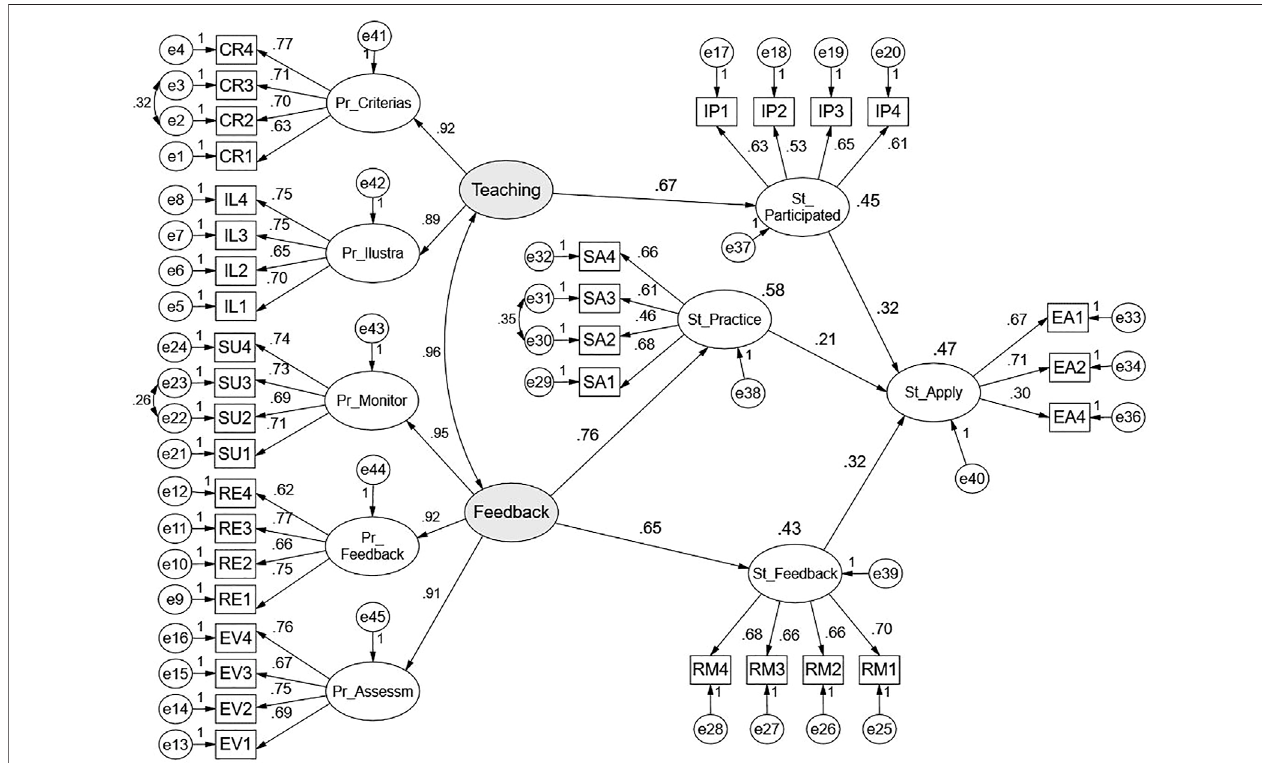
FIGURE 3 | Structural regression model of Teaching and Feedback perceived on the students ’ didactic performances. Note. Teaching performance variables: teaching, feedback, Pr_Criterias = criteria explicitness, Pr_Ilustra = illustration, Pr_Monitor = supervision – monitoring, Pr_Feedback = feedback, Pr_Assessm =